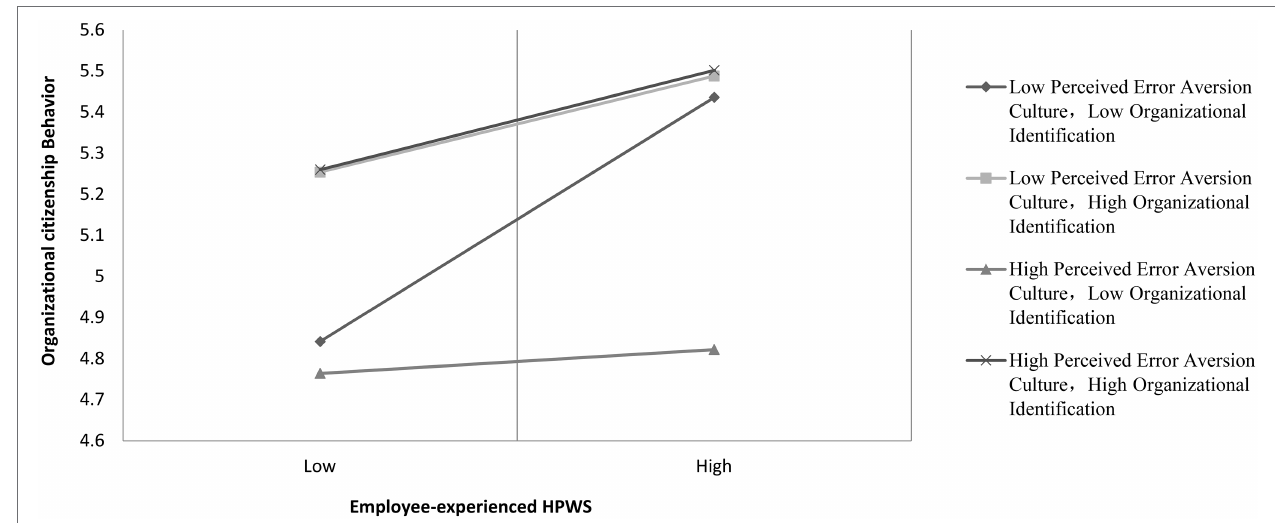
FIGURE 3 | The three-way interactive effects of HPWS, perceived error aversion culture, and organizational identification on OCB.